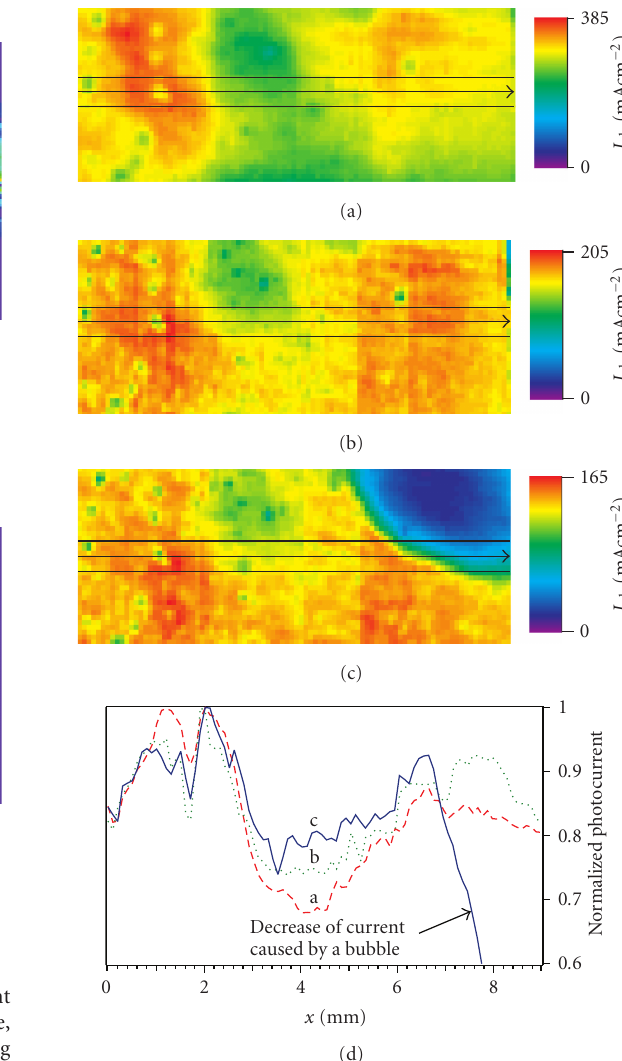
Figure 7: Photocurrent profiles at the same position across a dye sensitized solar cell with inhomogeneous photocurrent distribution. Measurements were done after di ff erent periods of illumination with simulated solar light. The photocurrent profiles smooth out during long-term photodegradation, because pho- todegradation is faster where large photocurrents are flowing. (Experiment performed with copper-chlorophylline on TiO 2 ): (a) before and (b) after 21 days, and (c) after another 93 days of illumination with simulated solar